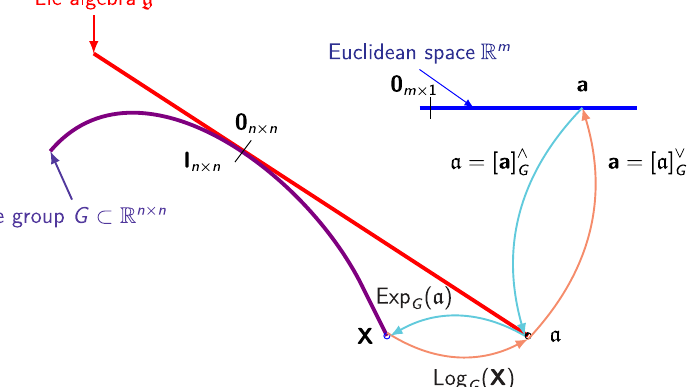
Figure 4. Relation between the Lie group, the Lie algebra, and the Euclidean space. For each element a ∈ R m , we associate an element a in Lie algebra, which is converted in aelement X of LG G , thanks ( . ) to the operator Exp ∧ G